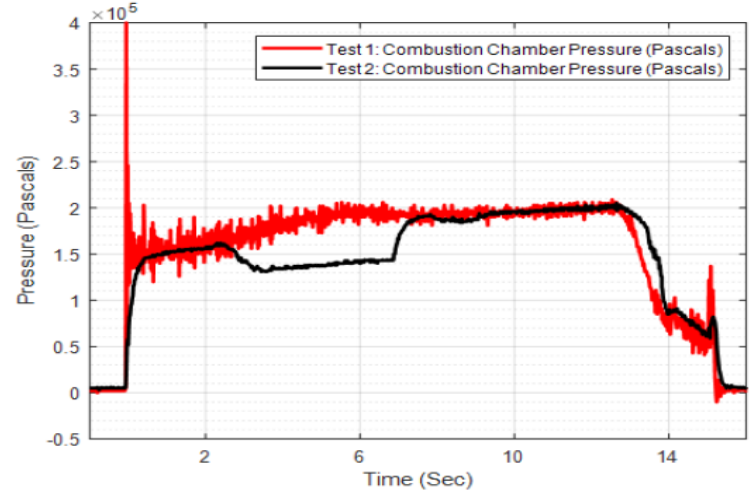
Figure 18. Test 1 and Test 2, combustion chamber pressure vs. burn time.